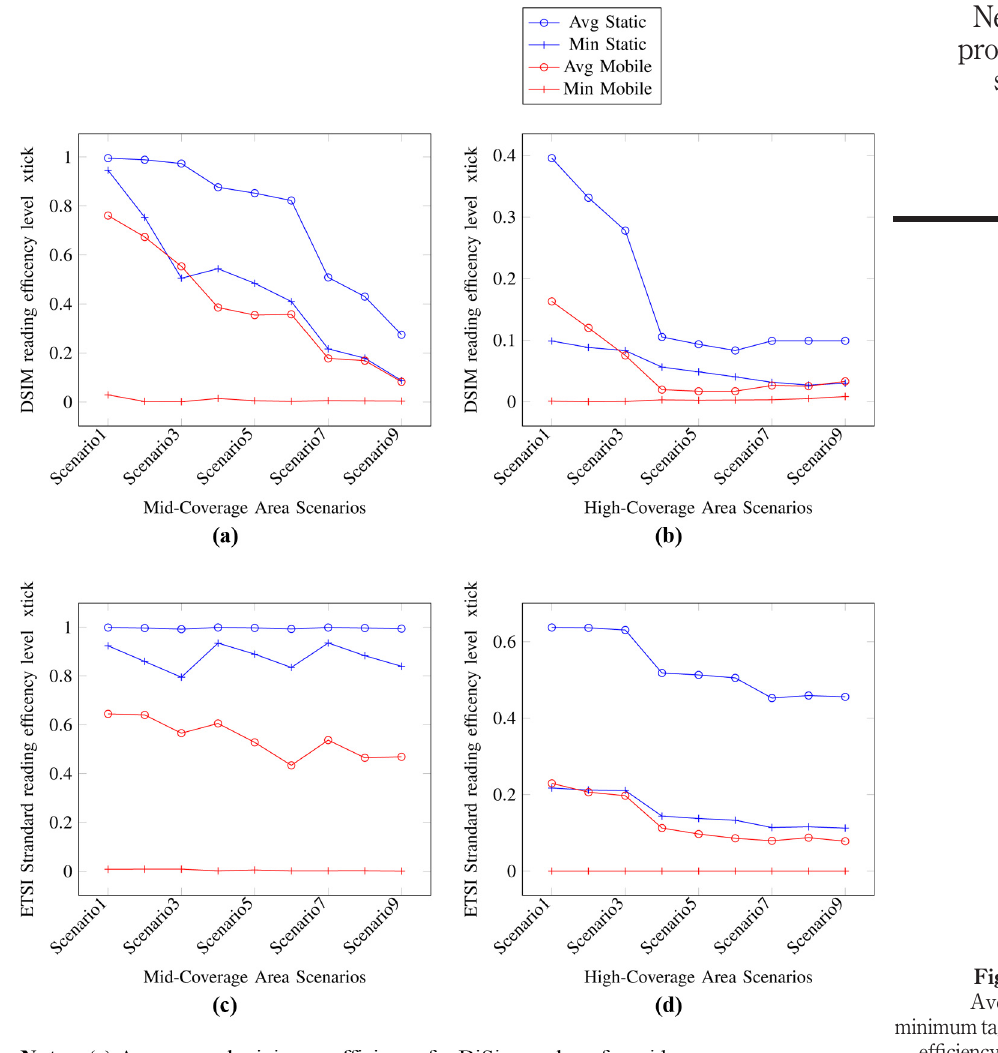
Figure A3. Average and minimum tag-reading ef fi ciency for static and mobile readers, for both mid and high-coverage